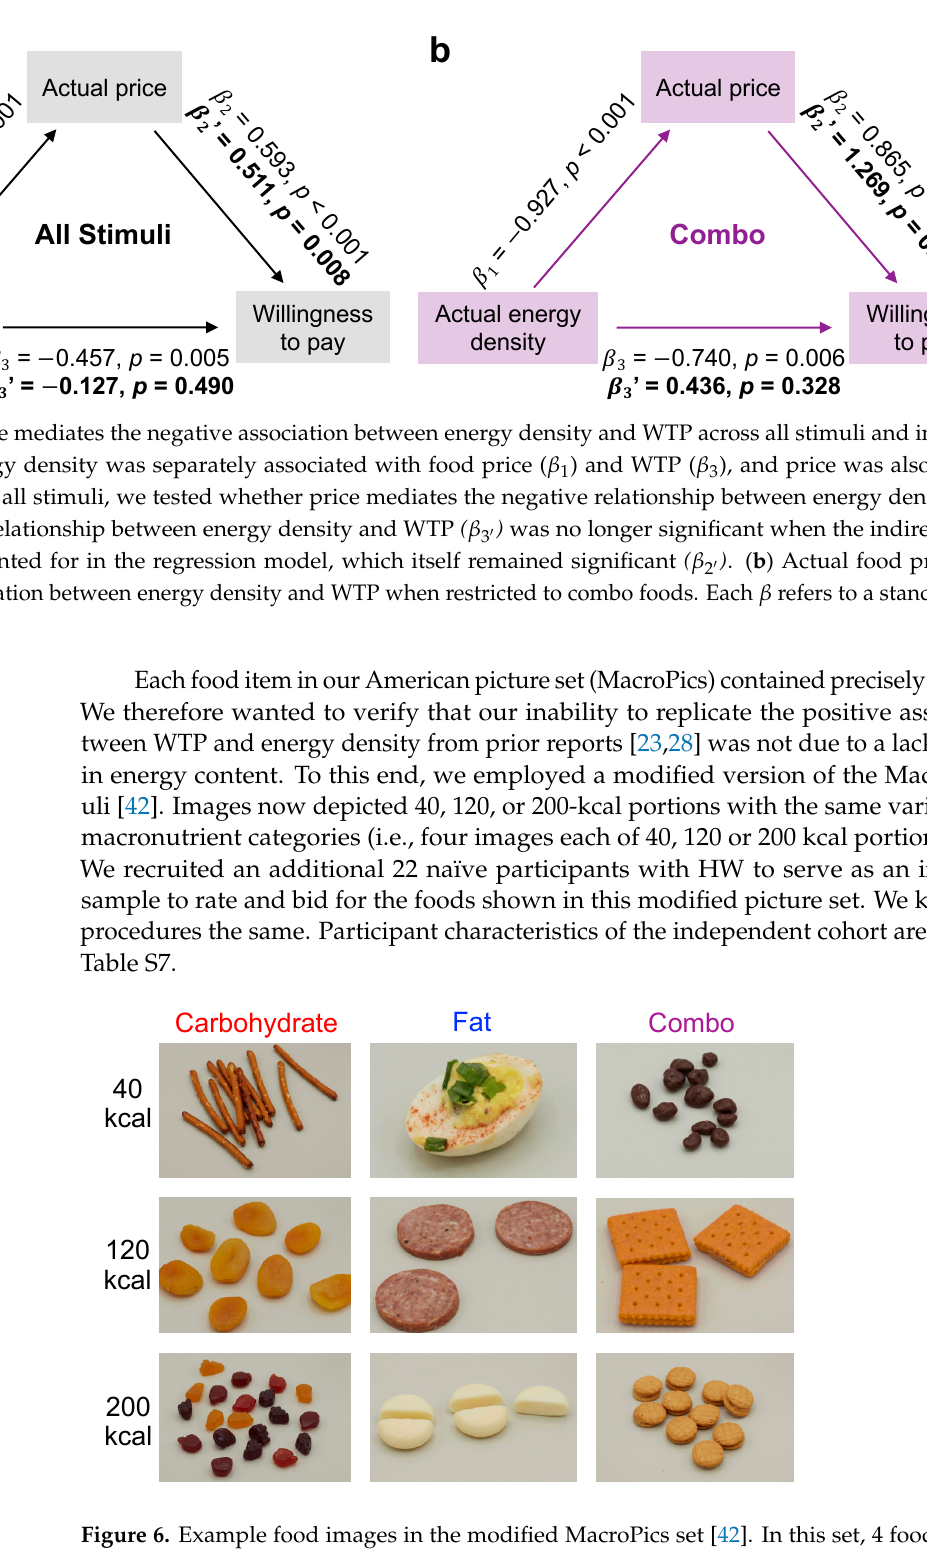
Figure 6. Example food images in the modified MacroPics set [42]. In this set, 4 foods each in the carbohydrate, fat, and combo categories are pictured in the following portions: 40, 120, or 200